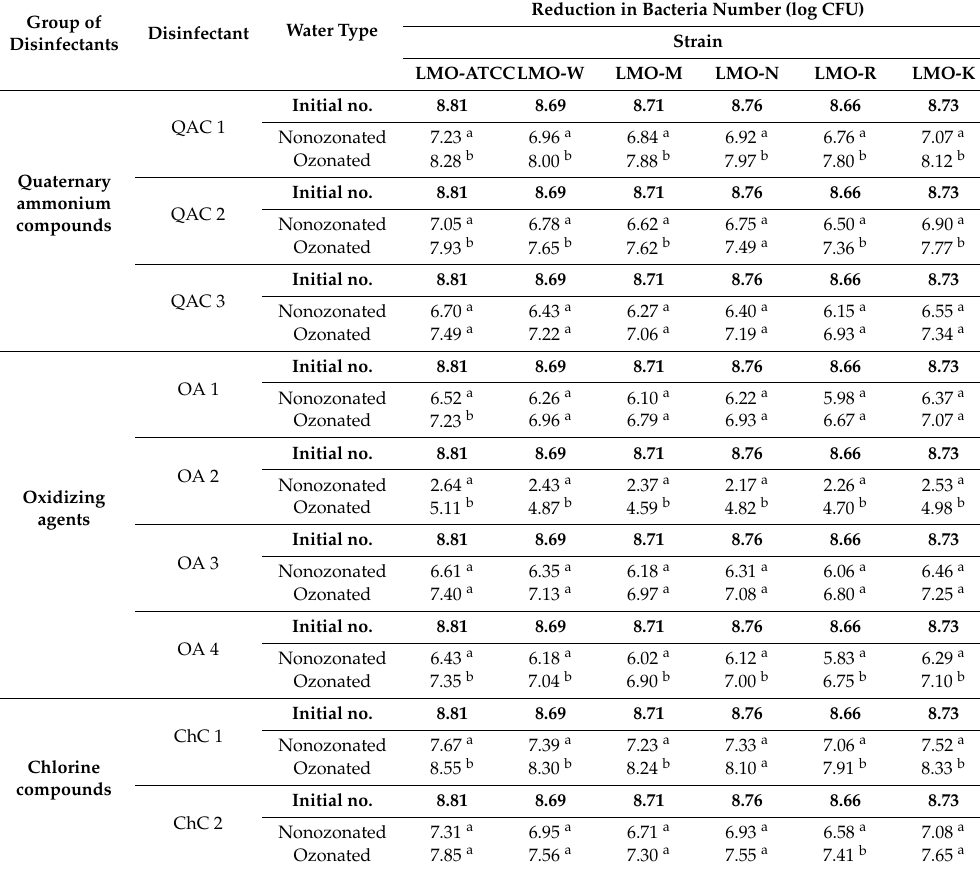
Table 4. Logarithmic decreases in bacteria number after using the disinfectant concentration directly preceding MBC